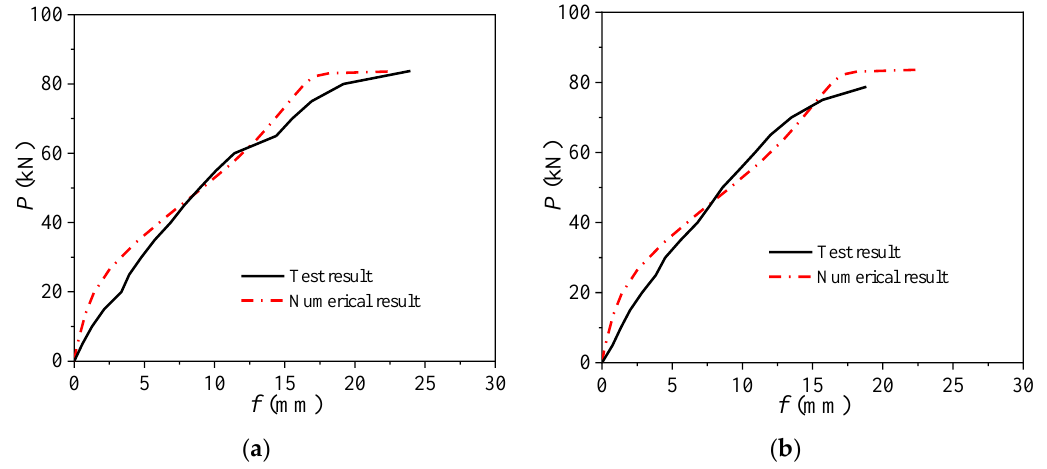
Figure 14. Load − displacement curve predicted from the FE models. ( a ) JJLH1. ( b ) JJLH2.